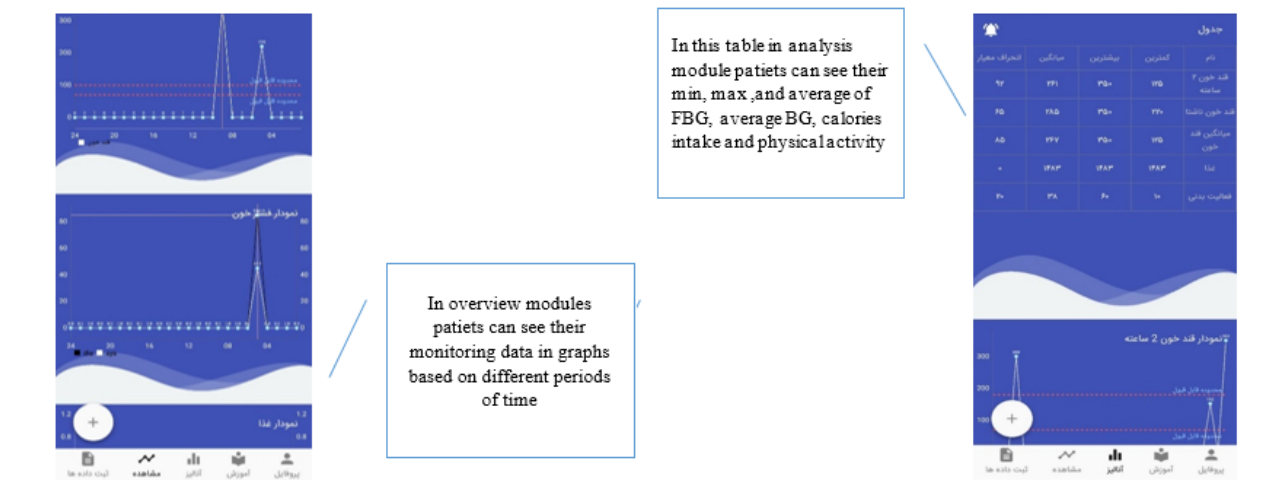
Figure 4. Overview and analysis module: participants can view the entered data in a chart format and see trends over time. Charts show physical activity range and calorie intake.